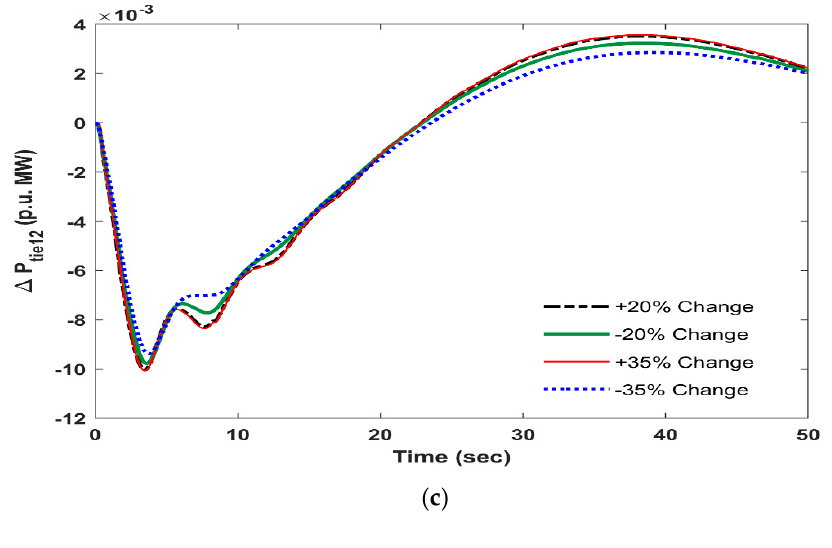
Figure 11. ( a – c ) LFC results for sensitivity analysis.